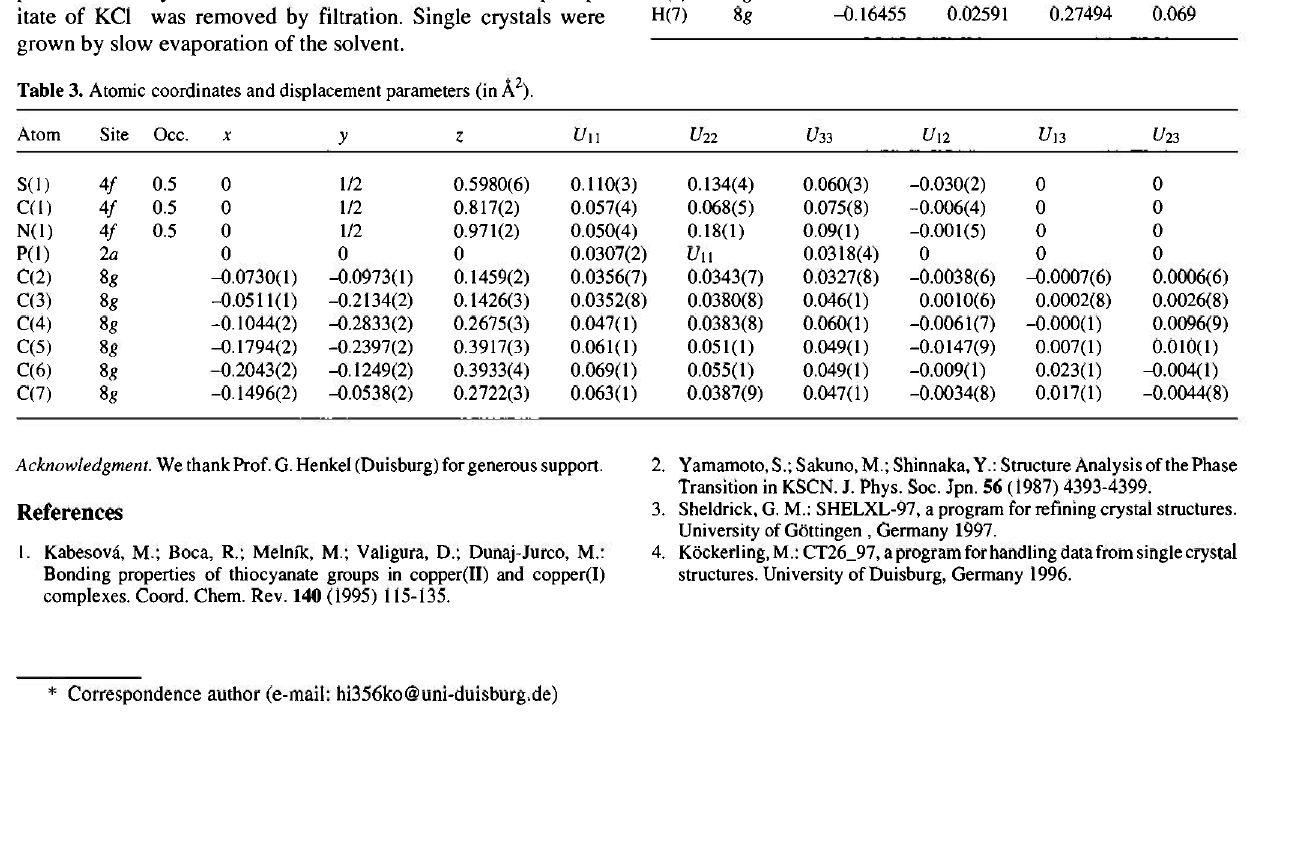
Table 3. Atomic coordinates and displacement parameters (in Ä 2 ).